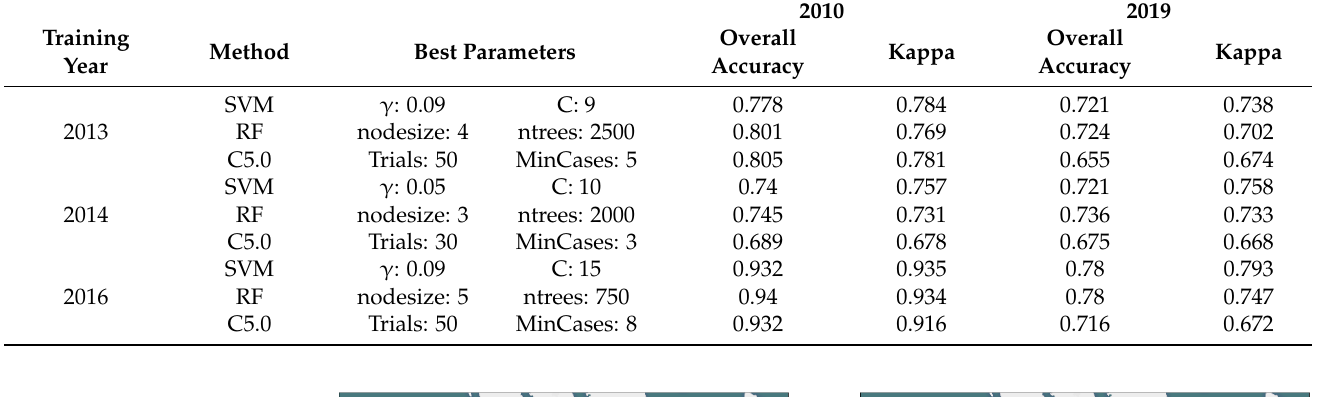
Table 2. Summary of optimal model parameters for each method and training year and the corre- sponding model performance measures for each validation year.